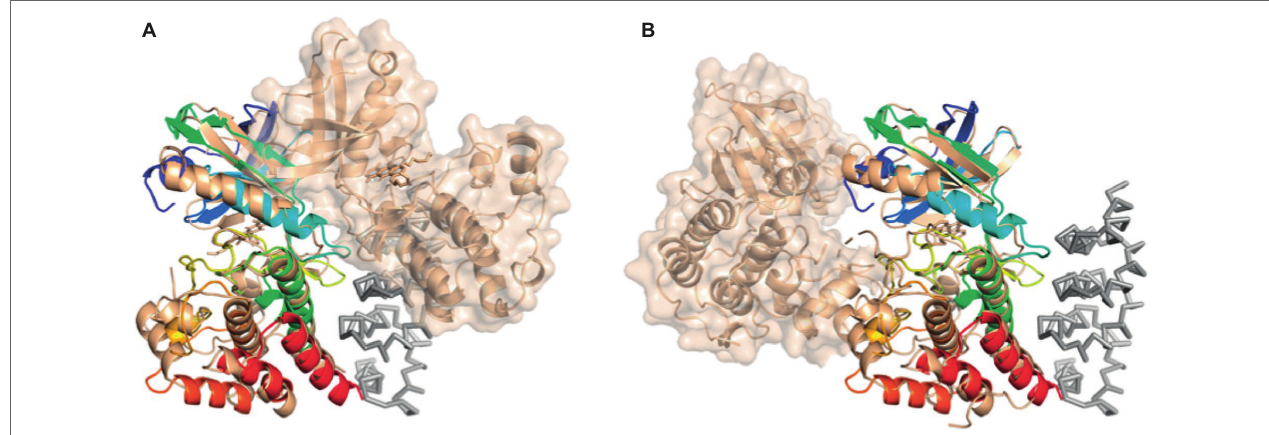
FIGURE 7 | Comparison of the bE8-YabT( ∆ TM) structure with the two types of PknB dimerization modes. YabT( ∆ TM) is shown as cartoon colored in rainbow scheme. bE8 is shown as ribbon colored in grey. The PknB subunits are shown as cartoon colored in beige. The surface of the PknB subunit, which is not superimposed on YabT( ∆ TM), is shown in transparency. (A) Superimposition with the back-to-back dimer of PknB (PDB ID 2FUM). (B) Superimposition with the face-to-face PknB dimer (PDB ID 3F69).